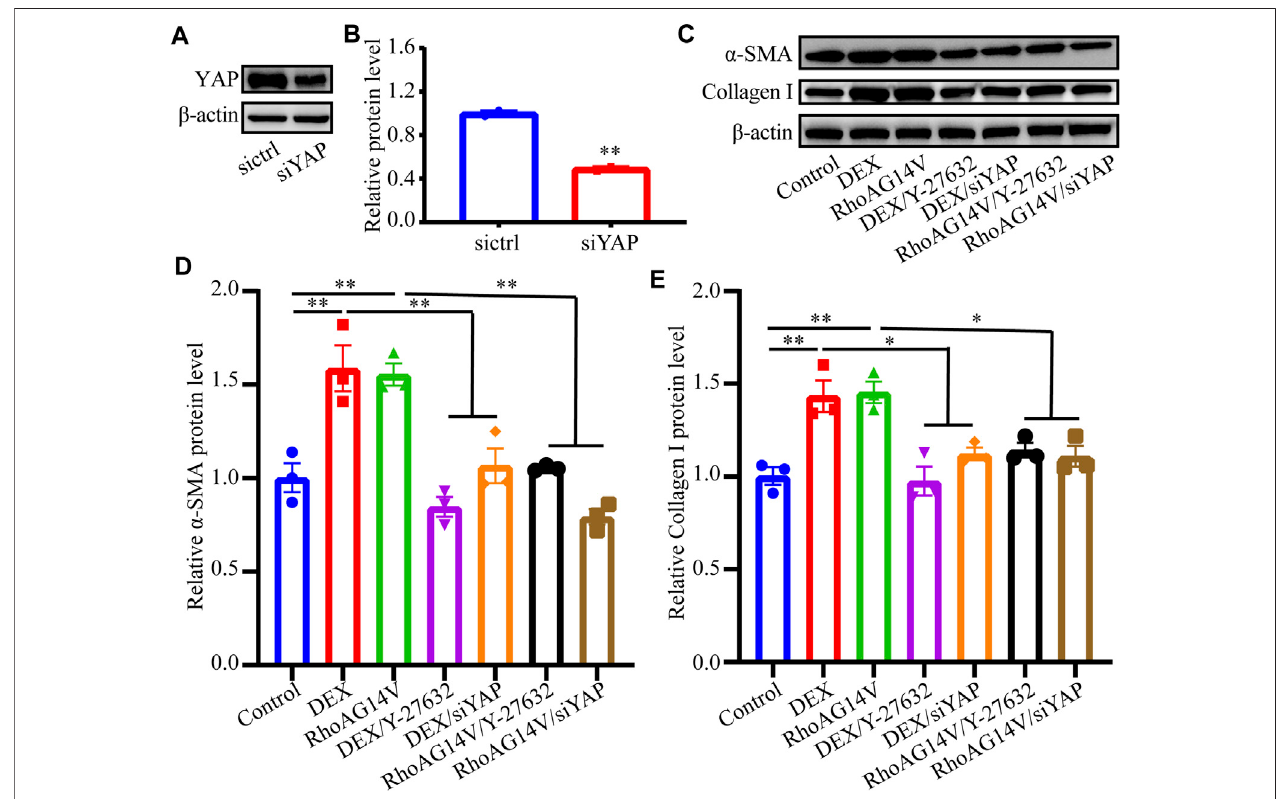
FIGURE8| InhibitionofROCKorYAPdecreasedtheexpressionofCollagenIand α -SMAproteinsinducedbyDEXorRhoAG14VinHTMcells (A) ThebandofYAP protein (B) The expression level of YAP was quanti fi ed by western blot using the indicated antibodies (C) The bands of α -SMA and Collagen I proteins (D,E) Quanti fi cation analyses of (D) α -SMA and (E) Collagen I proteins in HTM cells treated with or without DEX, ROCK inhibitor Y-27632, RhoAG14V and siYAP were evaluated by western blot. * p < 0.05; ** p < 0.01.